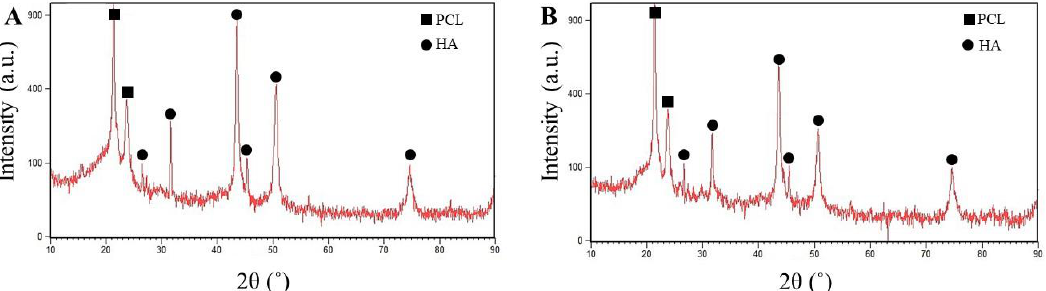
Figure 6. XRD patterns of PCL/Ge nanofibers containing ( A ) 1 and ( B ) 3% of forsterite after 21 days of immersion in SBF.